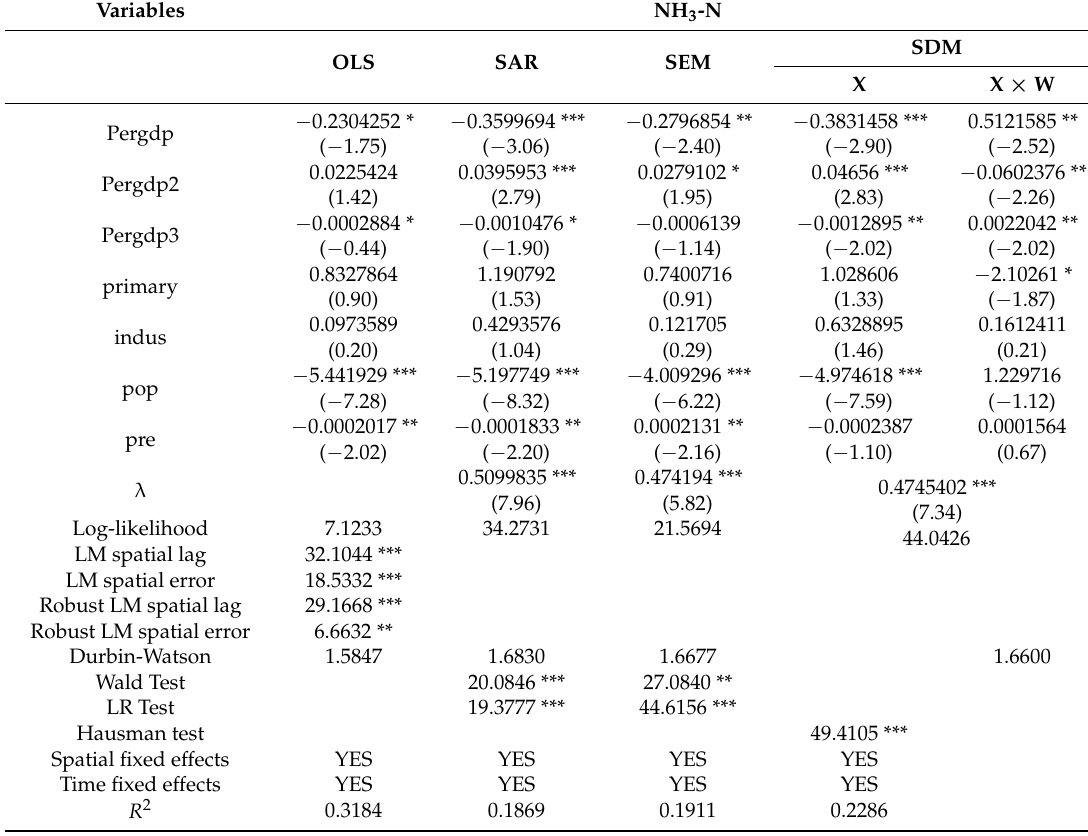
Table 5. Estimation results for NH 3